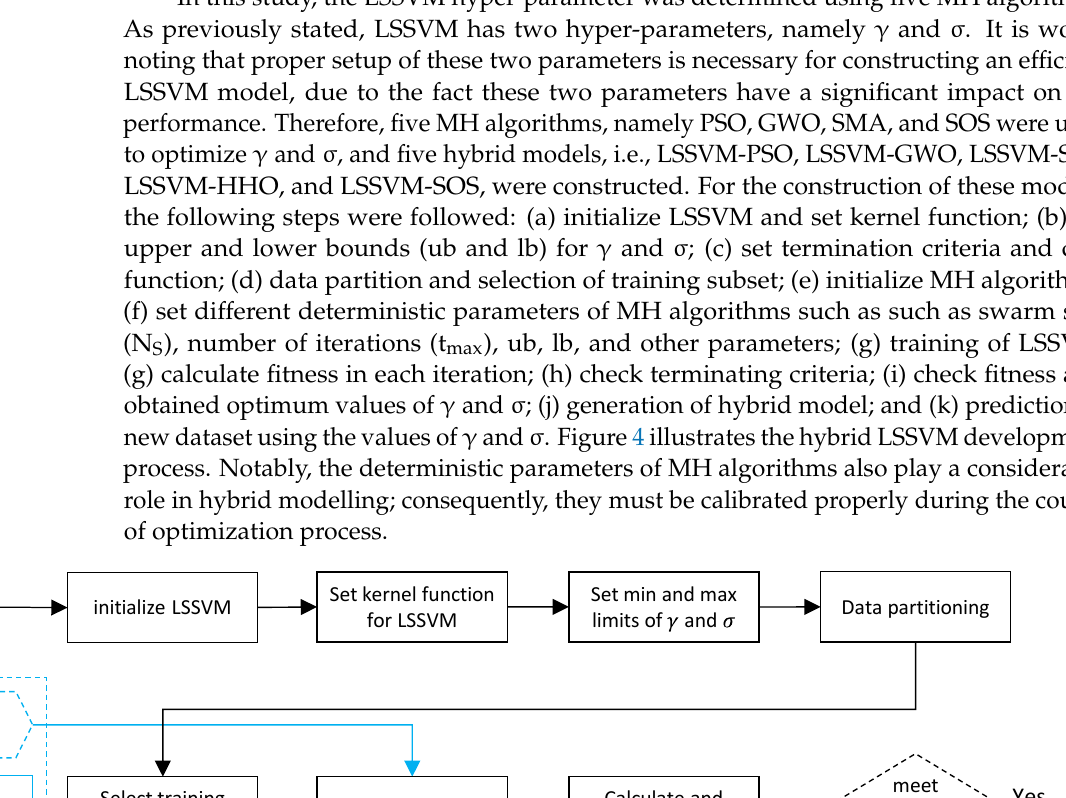
Figure 3. ( a – f ) Frequency histogram for the input and output parameters.